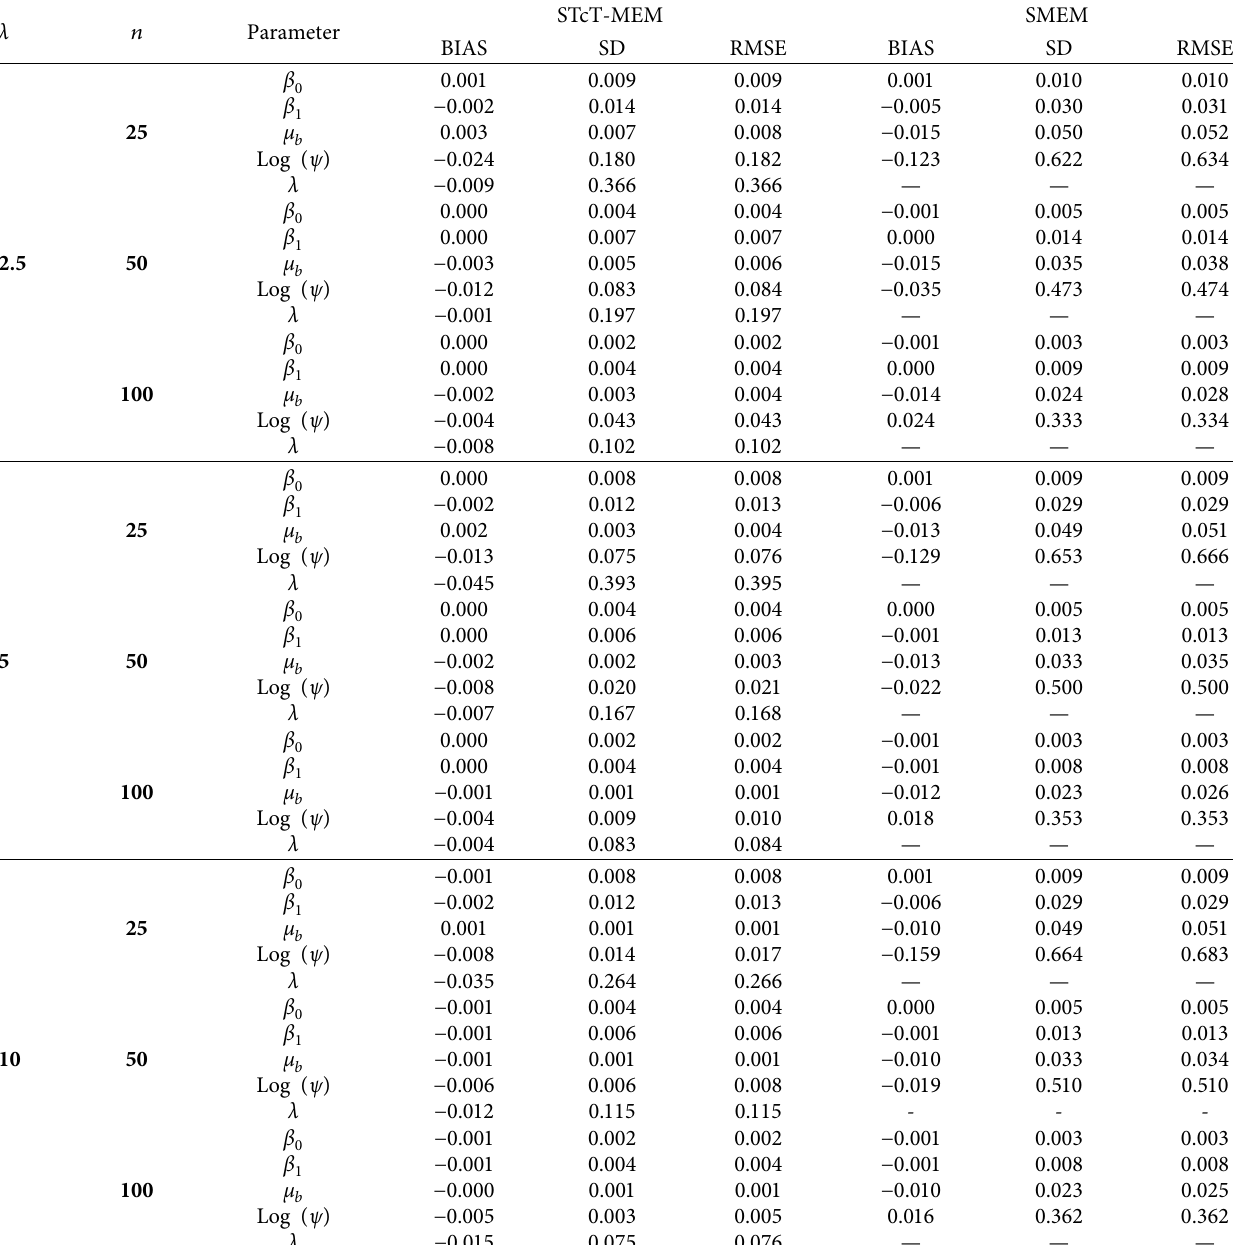
Table 2: Simulated bias, sample standard deviation (SD), and root mean square error (RMSE) of ML for the STcT-MEM and SMEM. λ n Parameter